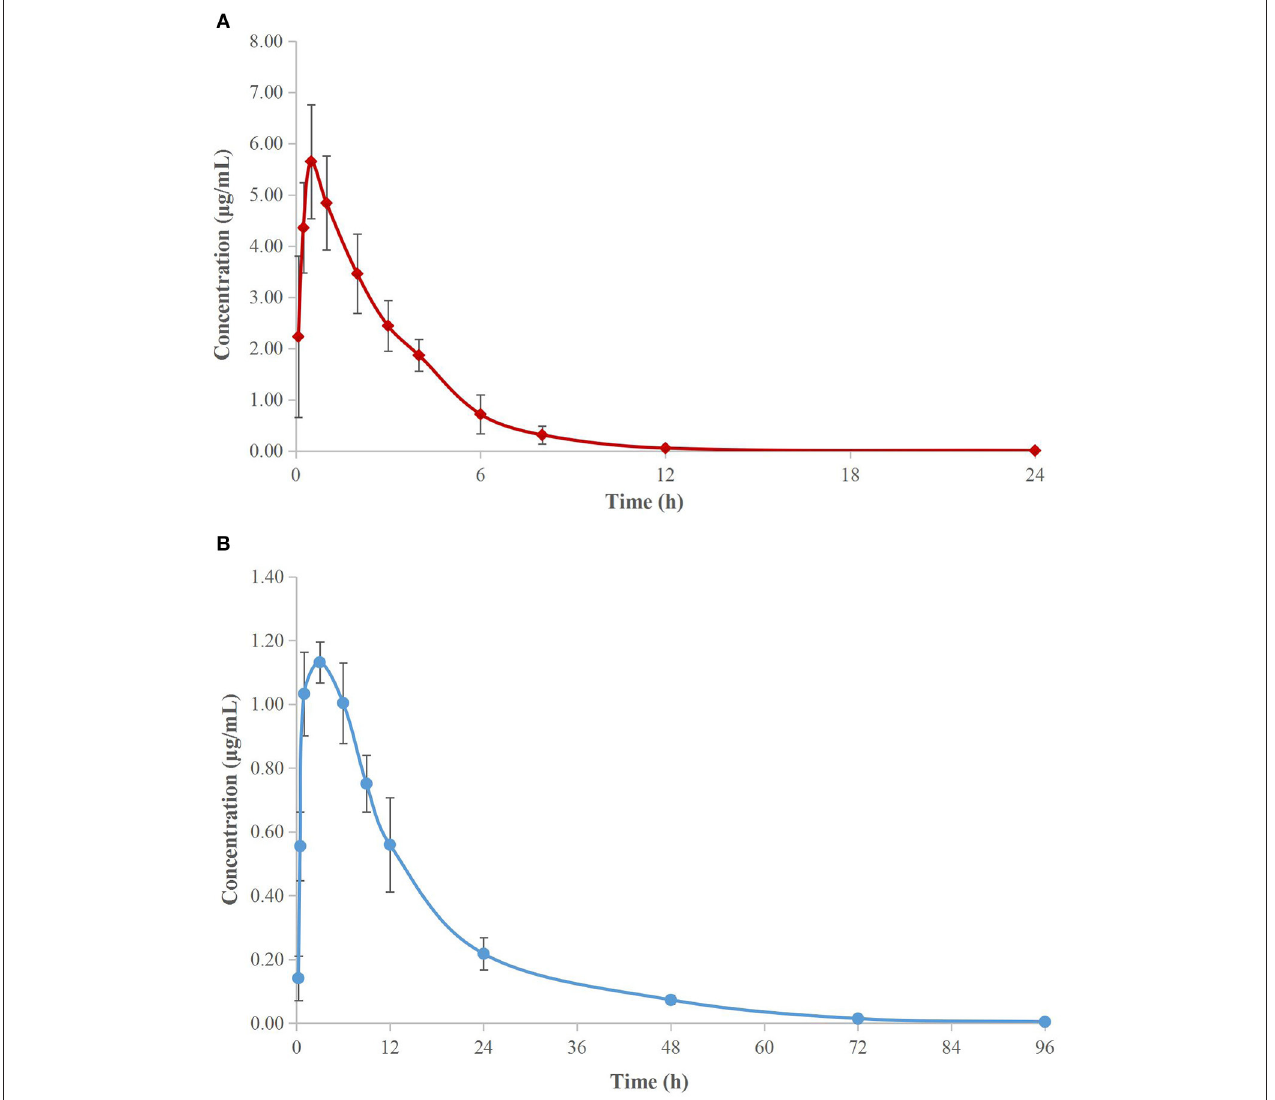
FIGURE 3 | Semi-logarithmic concentration-time curves of cefquinome in porcine serum (A) and TCF (B) . Values are the mean ± standard deviation ( n = 6).